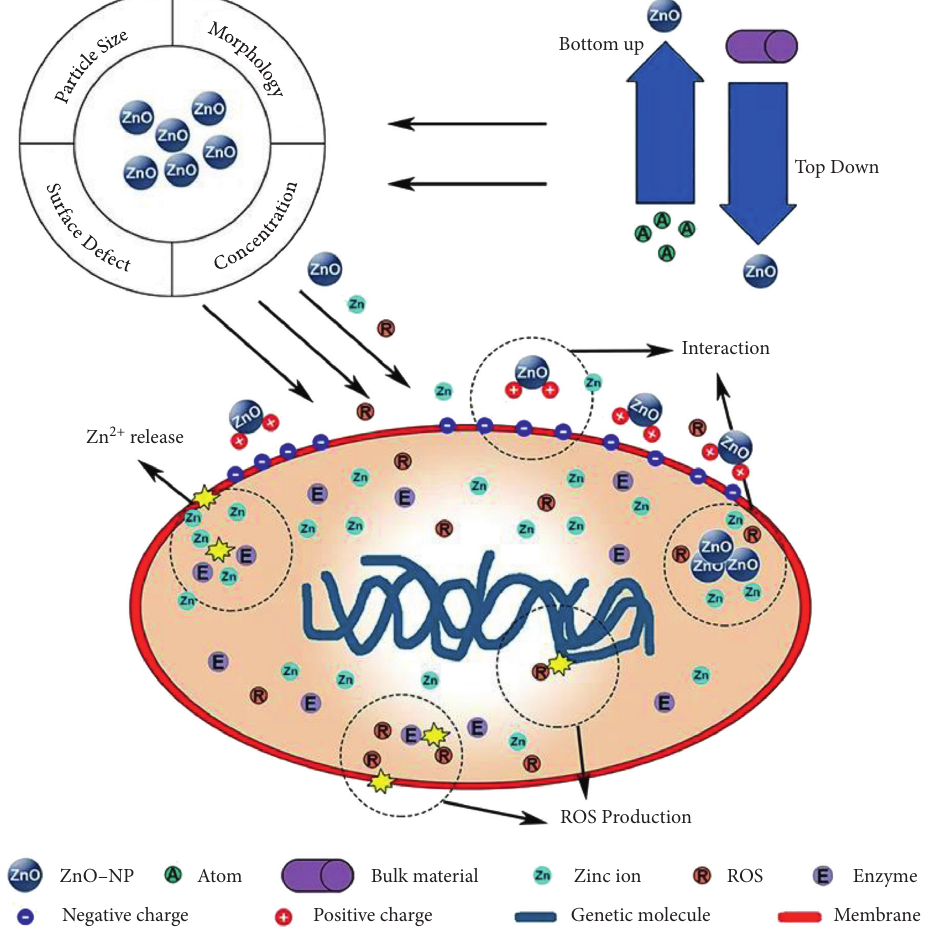
Figure 8: Antibacterial mechanism of ZnNPs